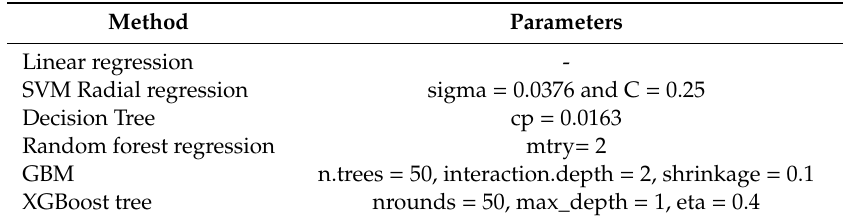
Table A2. Final Parameters for Comments